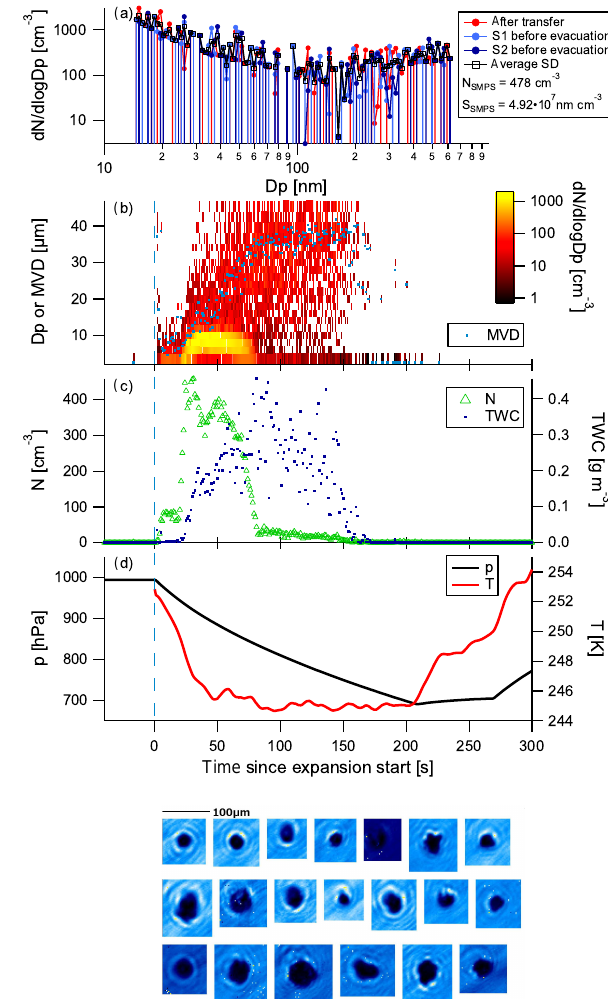
Figure 6. Control experiment using kaolinite dust (experiment 11; see Table 1). Panels as in Fig. 4; the data shown here stem from the first run, using a high pump speed. The data show formation of ice in a second mode, and the decrease and almost disappearance of particle numbers of smaller drops over time (Wegener–Bergeron– Findeisen